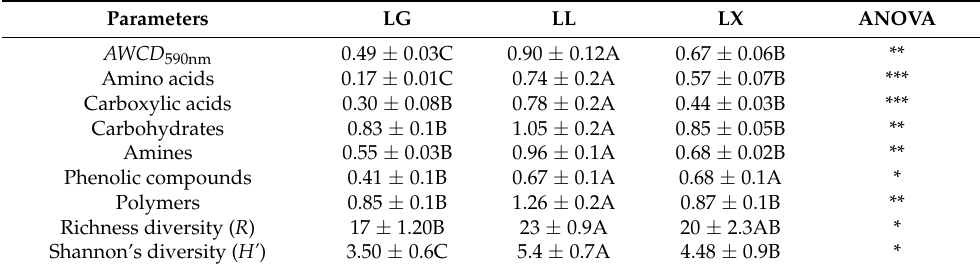
Table 3. Functional diversity of water bacterial communities associated with Geming lake (LG), Lianhu lake (LL), and Xingqing lake (LX) in Xi’an City, Shaanxi Province,